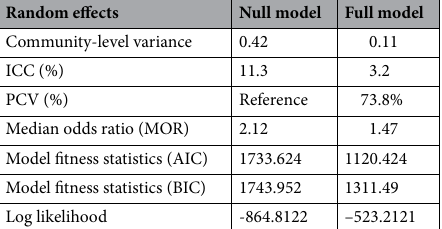
Table 2. The random-effects model and model